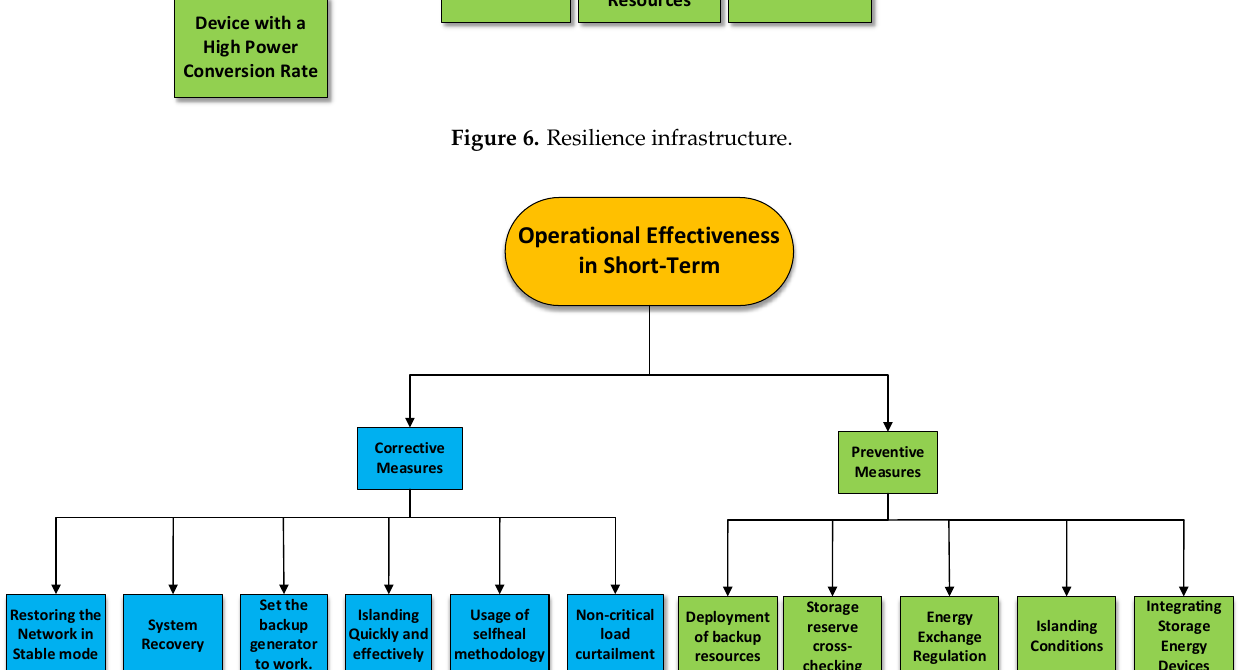
Figure 6. Resilience infrastructure.